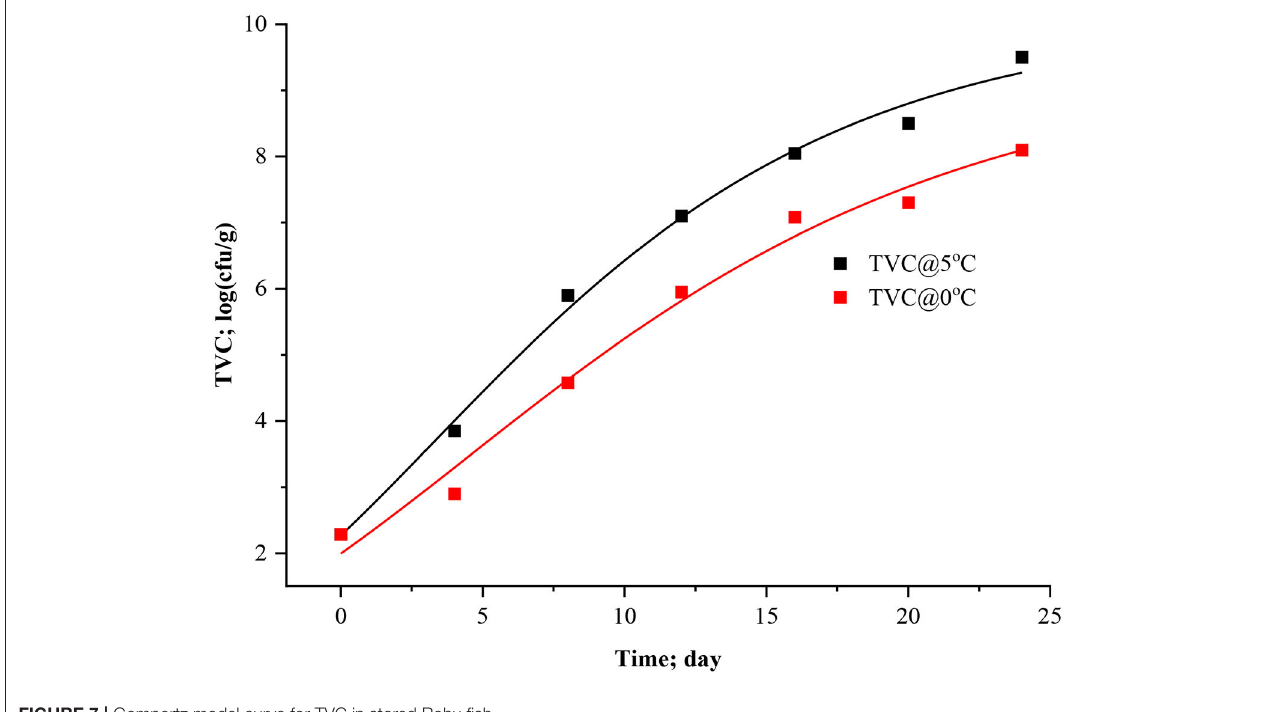
FIGURE 7 | Gompertz model curve for TVC in stored Rohu fish.